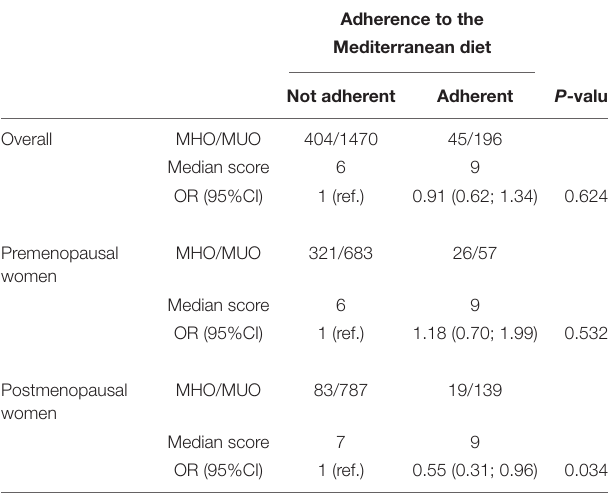
TABLE 4 | Association between the adherence to the Mediterranean diet risk of metabolically unhealthy